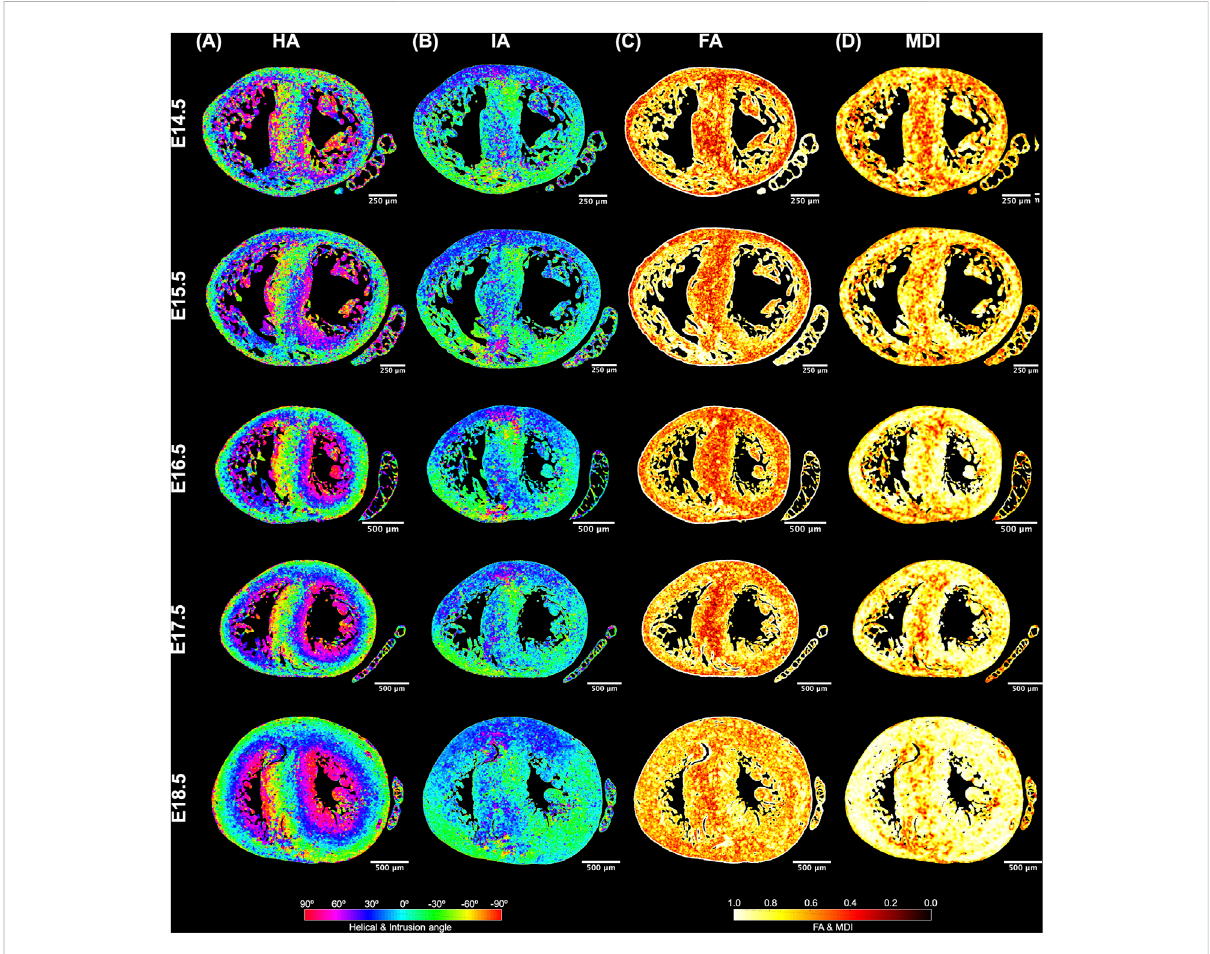
FIGURE 4 Quanti fi cation of myocyte aggregates orientation [ via helical (HA) and intrusion angle (IA)] and myocyte aggregates organisation [ via fractional anisotropy (FA) and myocardial disarray index (MDI)]. Local HA (A) , IA (B) , FA (C) and MDI (D) at mid-ventricular level, at E14.5, E15.5, E16.5, E17.5 and E18.5 days of